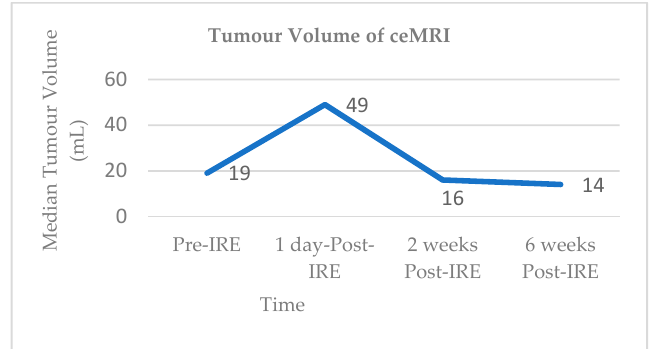
Figure 1. Median tumour volumes on contrast enhanced MRI (ceMRI).